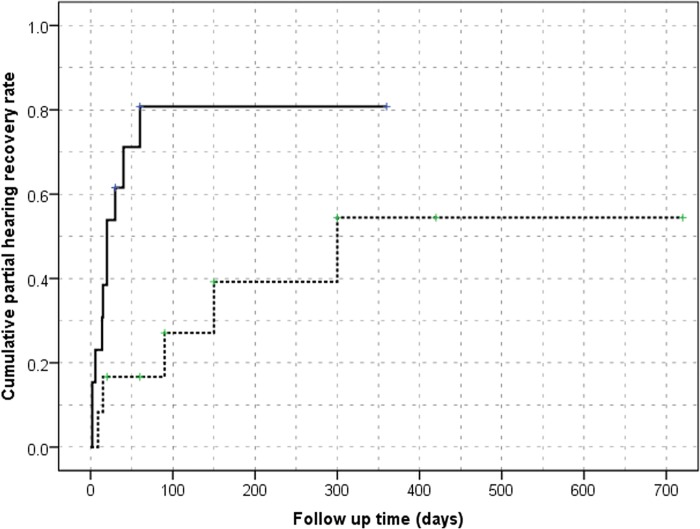
Cumulative partial response rates of patients with normal MRI findings (broken line) and those with an ILH or labyrinthitis (solid line) after propensity score matching.The hazard ratio of a poor response for patients with ILH or labyrinthitis was 1.606 (95% confidence interval: 1.03–2.50).